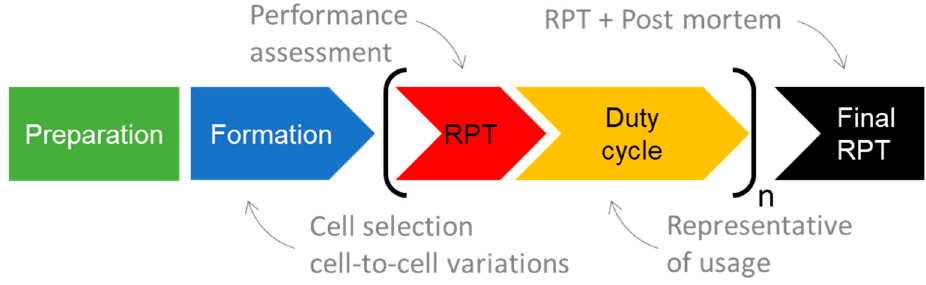
Figure 1. Testing sequence within proposed protocols.